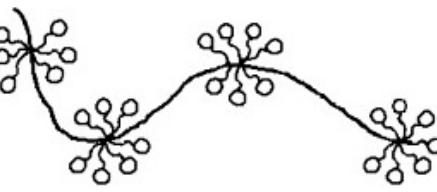
Figure 5. Schematic illustration of the necklace-like structure of casein-sodium dodecyl sulphate complexes. Reproduced with permission from [64], copyright by Elsevier Science Ltd., 2007.